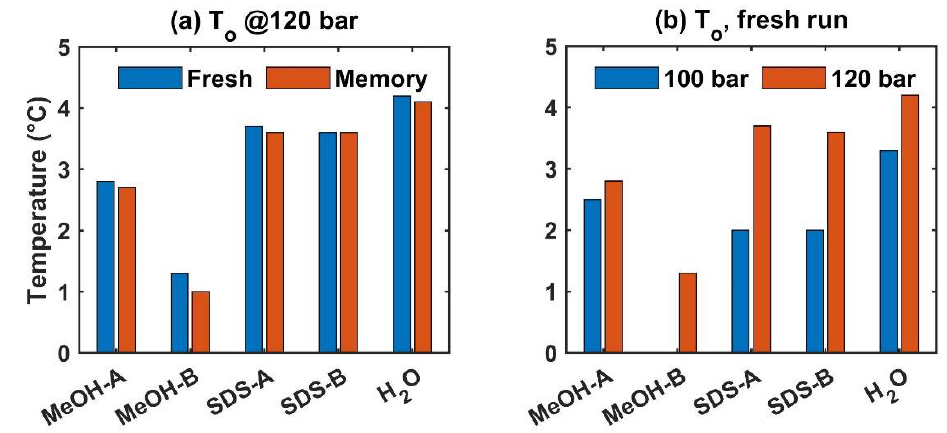
Figure 10. T o under 120 and 100 bar for fresh and memory runs. ( a ) Onset temperature T o under 120 bar for fresh and memory runs. ( b ) T o during fresh runs under 100 bar and 120 bar, respectively.